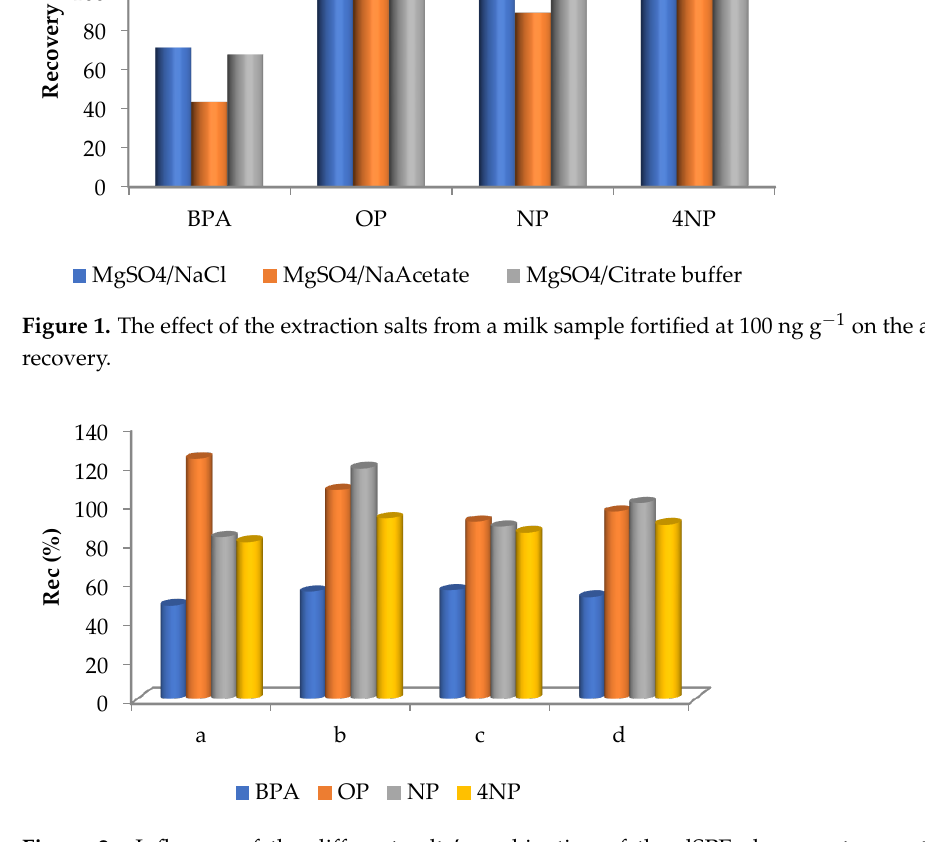
Figure 1. The effect of the extraction salts from a milk sample fortified at 100 ng g −1 on the analytes’ recovery.